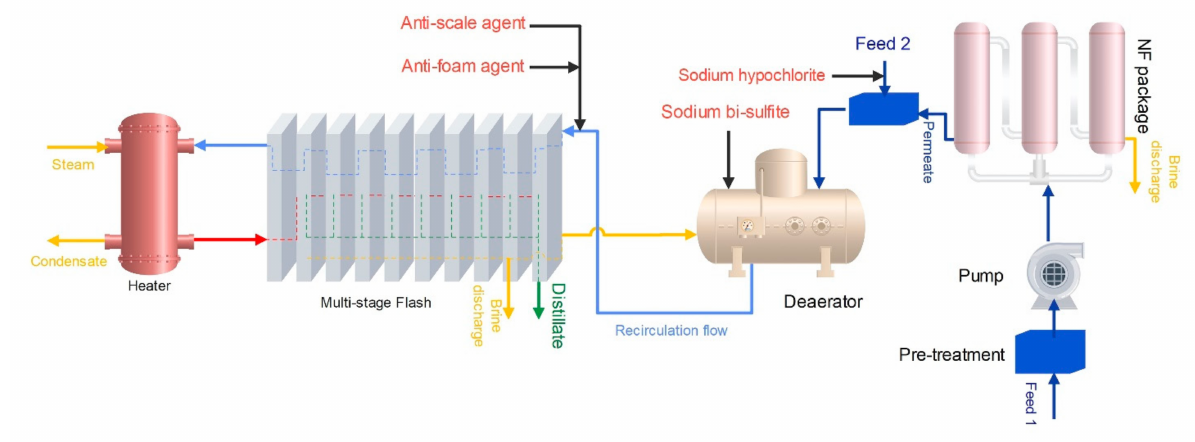
Figure 4. The schematic of case 3 (hybrid